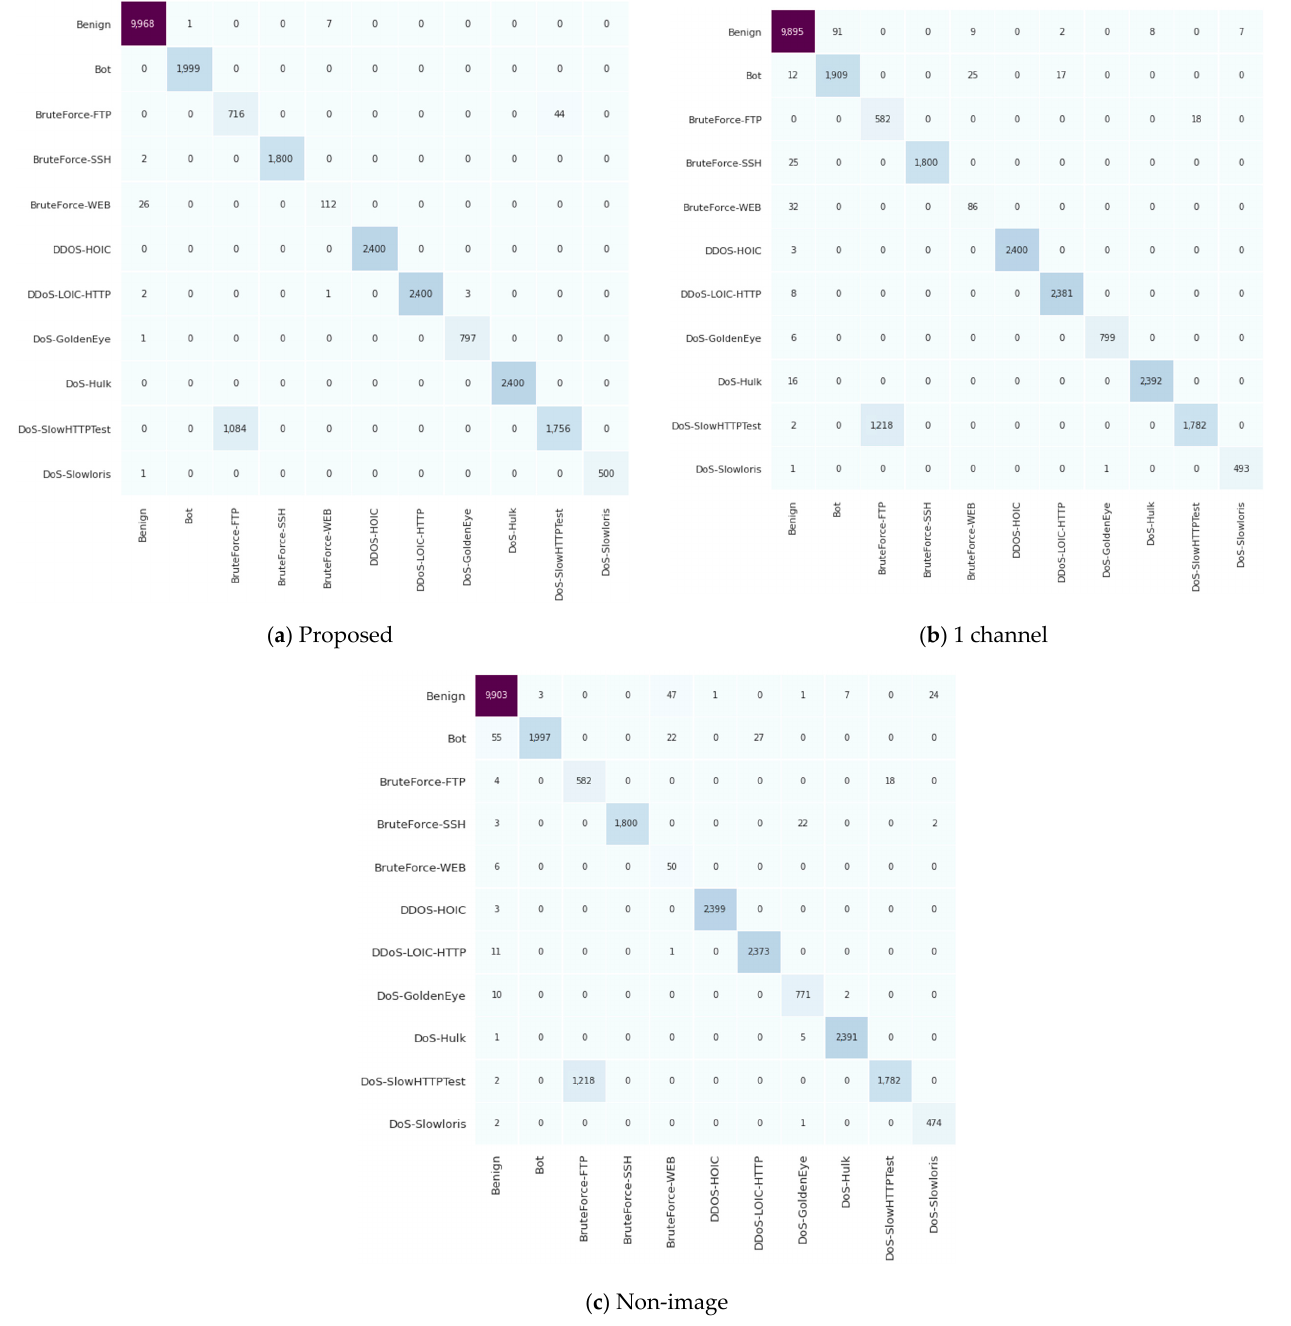
Figure 8. CSE-CIC-IDS2018 Confusion matrix. Each row shows predicted result for each